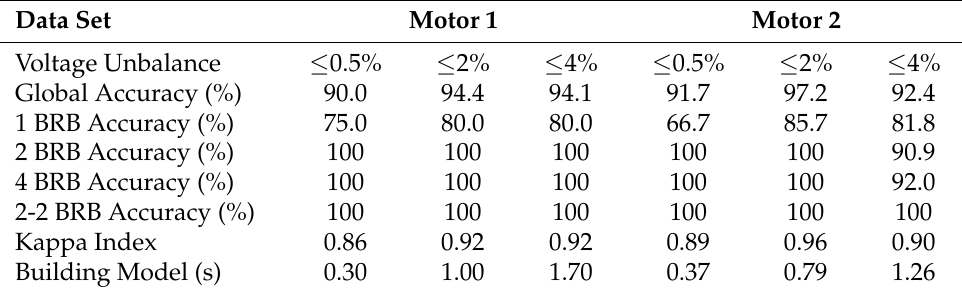
Table 5. Experimental results using the 150 SMI attributes between phase currents i a and i b —Severity analysis of rotor